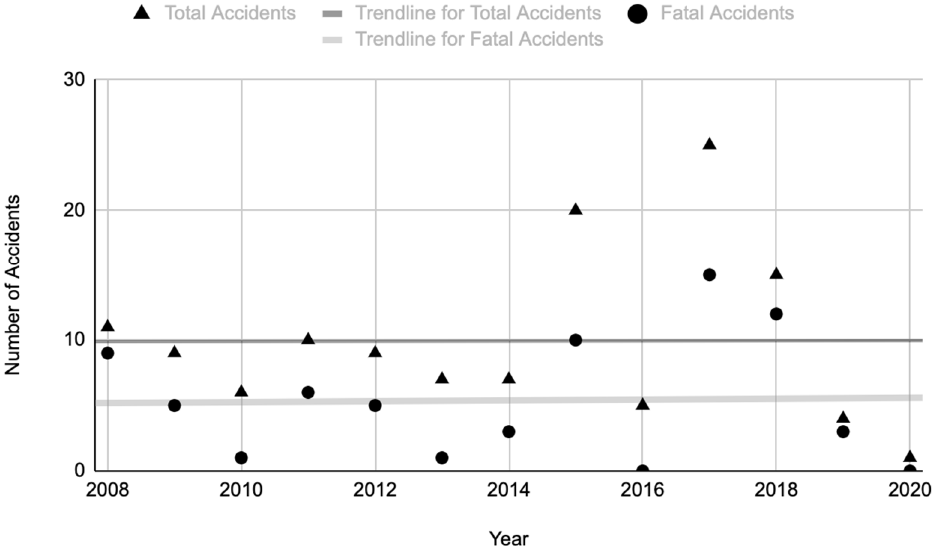
Figure 1. Total number of loss of visual reference accidents per year (represented with triangles) and total number of fatal accidents per year reporting a loss of visual reference (represented with circles). The lines represent the least squares trend line.